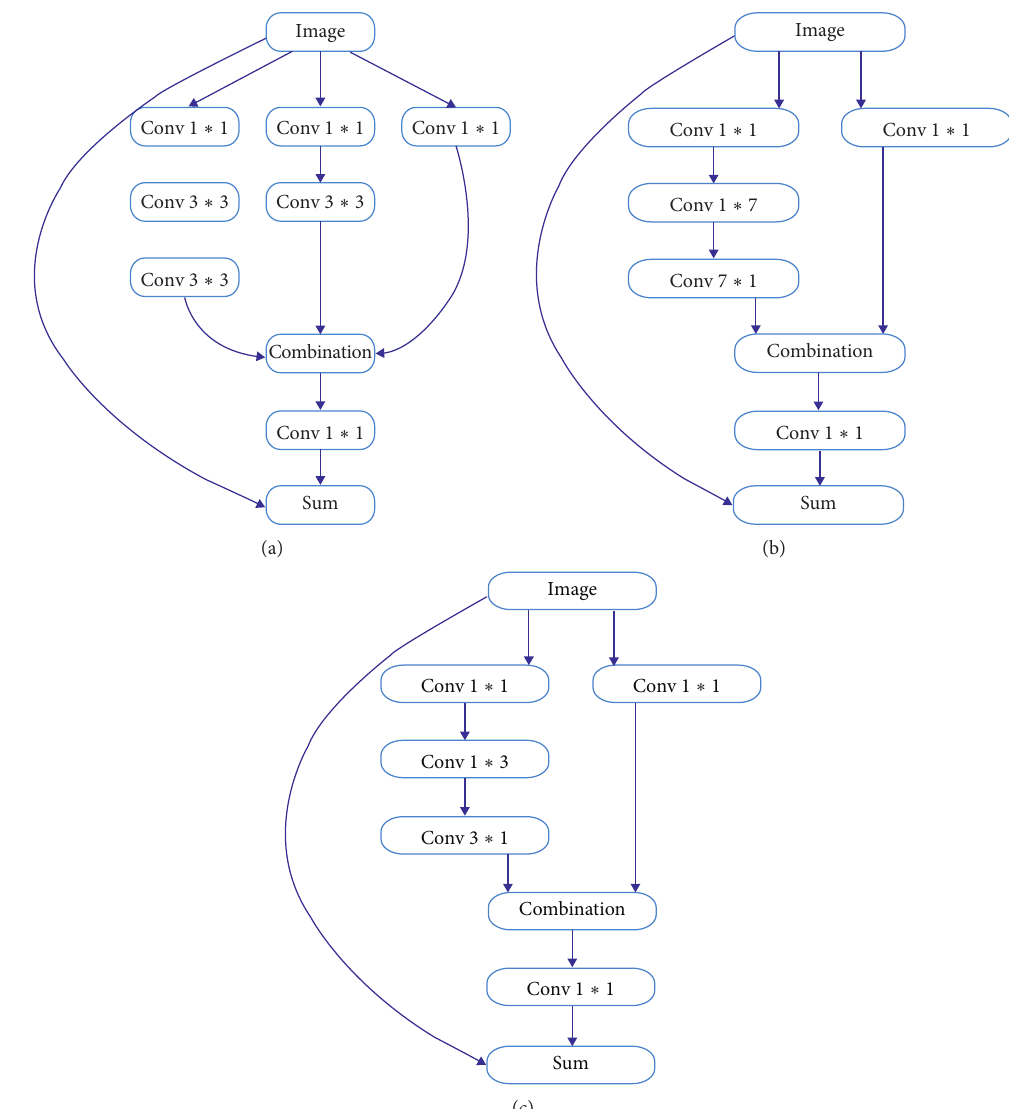
Figure 3: (a) ResNet-Inception-1 structure; (b) ResNet-Inception-2 structure; (c) ResNet-Inception-3